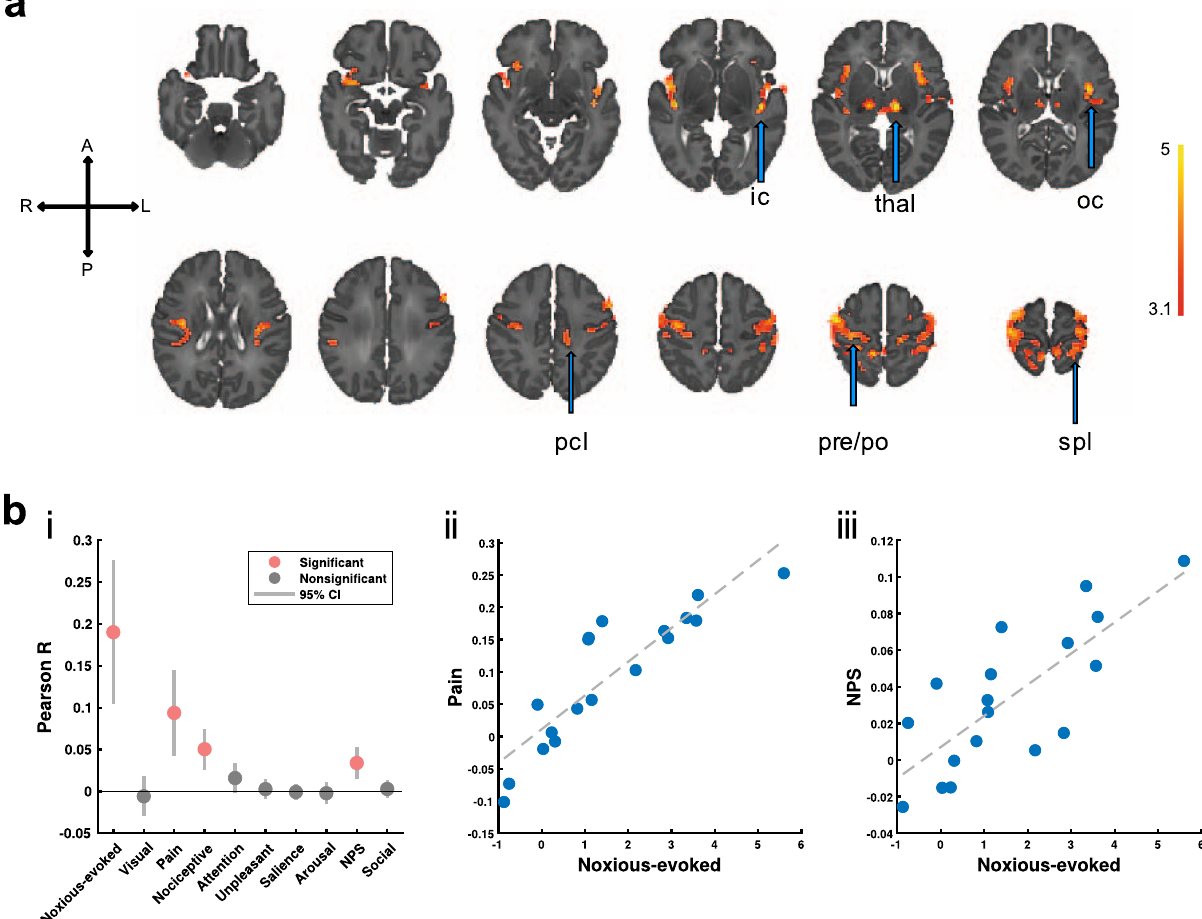
Fig. 2 Noxious-evoked responses are pain-relevant signals. a The thresholded group average noxious-evoked map displays t-statistics in statistically signi fi cant clusters (t-statistics are scaled according to colour bar). Activity is localised to regions classically considered part of the adult nociceptive pain system, including the pre- and post-central gyri (pre/po), paracentral and superior parietal lobules (pcl and spl), opercular and insular cortices (oc and ic), and thalamus (thal). A, P, L, R = anterior, posterior, left, right. bi For each infant, expression of functional templates ( x -axis) is assessed as whole-brain Pearson correlations between the template and neonates ’ noxious-evoked response maps ( y -axis). Group average template expression was assessed using two-tailed t -tests ( n = 18). Grey and red dots represent the group mean correlation coef fi cient, with grey bars displaying 95% con fi dence intervals (CI). The templates used included one map derived from the current neonatal dataset (Noxious-evoked), seven Neurosynth maps (Visual to Arousal), and two pain subtype signature maps (NPS and Social). The thresholded noxious-evoked map (displayed in part a) is a positive control. Visual is the Neurosynth negative control, and Social Rejection Pain is the pain signature negative control. The Neurologic Pain Signature (NPS) and Neurosynth Pain and Nociceptive templates were signi fi cantly expressed in this group of neonates, while none of the negative controls or other Neurosynth templates were signi fi cantly expressed. ii-iii Using two-tailed Pearson correlation tests to assess inter-subject variability in noxious-evoked responses, associations exist between the overall noxious-evoked response amplitudes (regression parameters) and both NPS and Neurosynth Pain correspondences (correlation coef fi cients): NPS Pearson r = 0.77 ( p = 0.0002), Neurosynth Pain Pearson r = 0.89 ( p = 0.0001). The dashed grey line is the least squares fi t. The stronger the neonatal BOLD response amplitude to the noxious stimulus, the closer the correspondence with both adult pain signatures. T -test and correlation test results for all templates are summarised in Table 1, and correlation plots for all Neurosynth and pain signature templates are displayed in Supplementary Fig. 9. Source data are provided as a Source Data fi